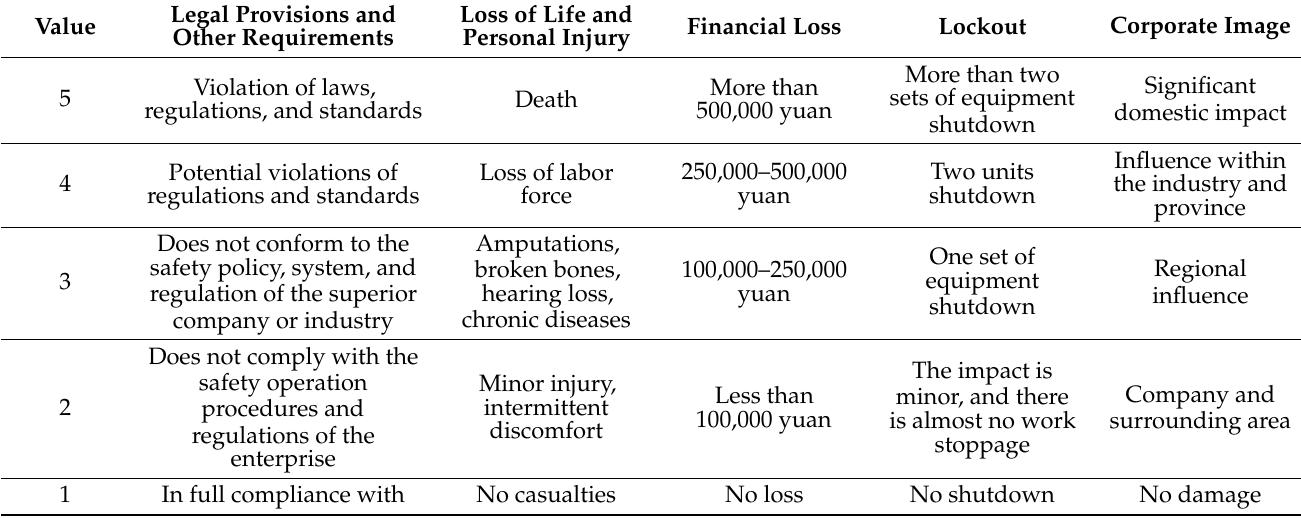
Table 5. Zhejiang Energy Natural Gas Group Co., Ltd., consequence severity grading.